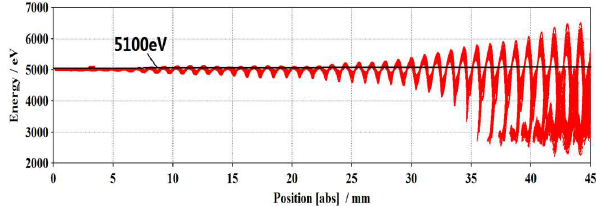
Figure 6. Electron kinetic energy versus longitudinal distance.